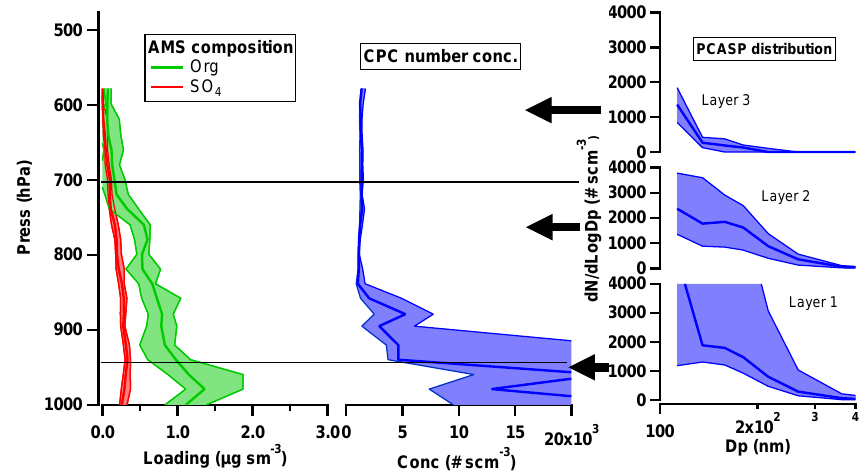
Fig. 13. Average altitude profile (median and interquartile ranges) during the MCS-dominated regime over Kota Kinabalu on the west coast of Borneo of organic and sulphate aerosol loading, number concentration and number size distributions for each layer. Aerosol number concentration is displayed on a larger scale than in other similar figures. Averages comprised six profiles from 16 July 2008 and 17 July 2008.